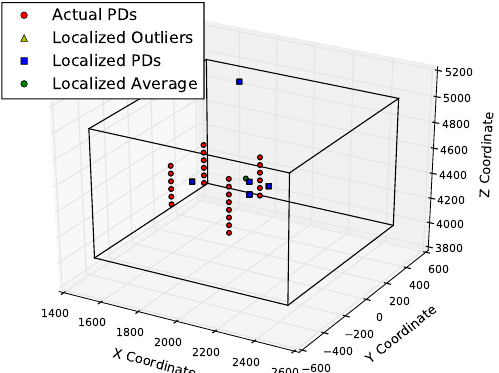
Figure 11. Localization results of multilateration on PD1 in KE20. The three axes are three dimensions of space (measured in mm).